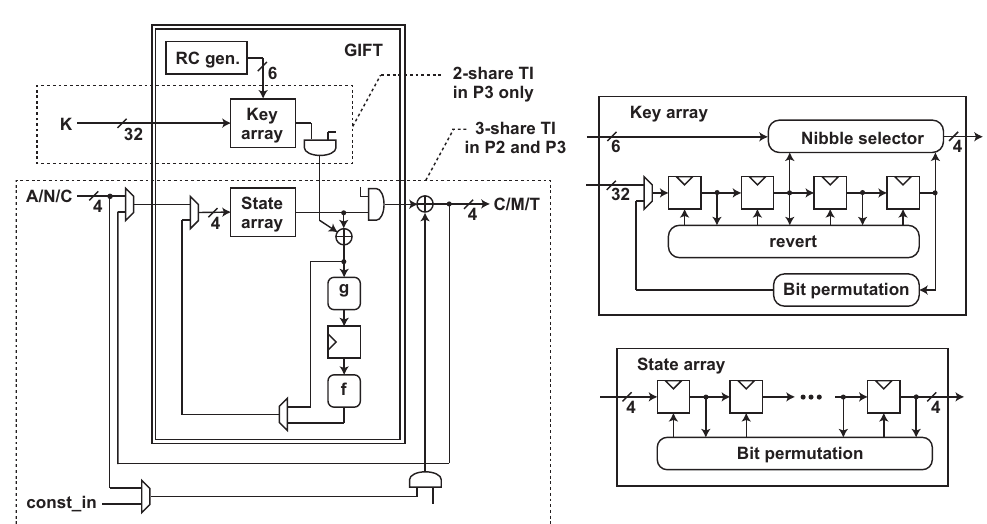
Figure 5: SAEB[GIFT] hardware